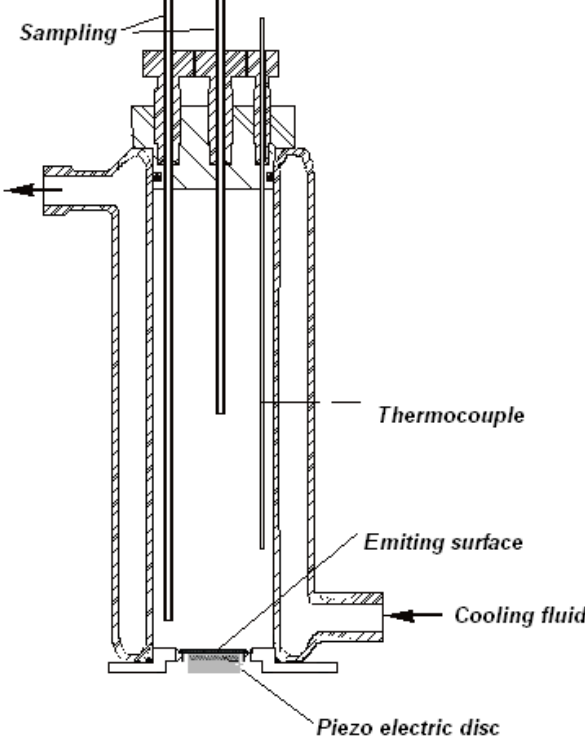
Figure 1. The general scheme of a sonochemical reactor operating in the high frequency range (200–2000